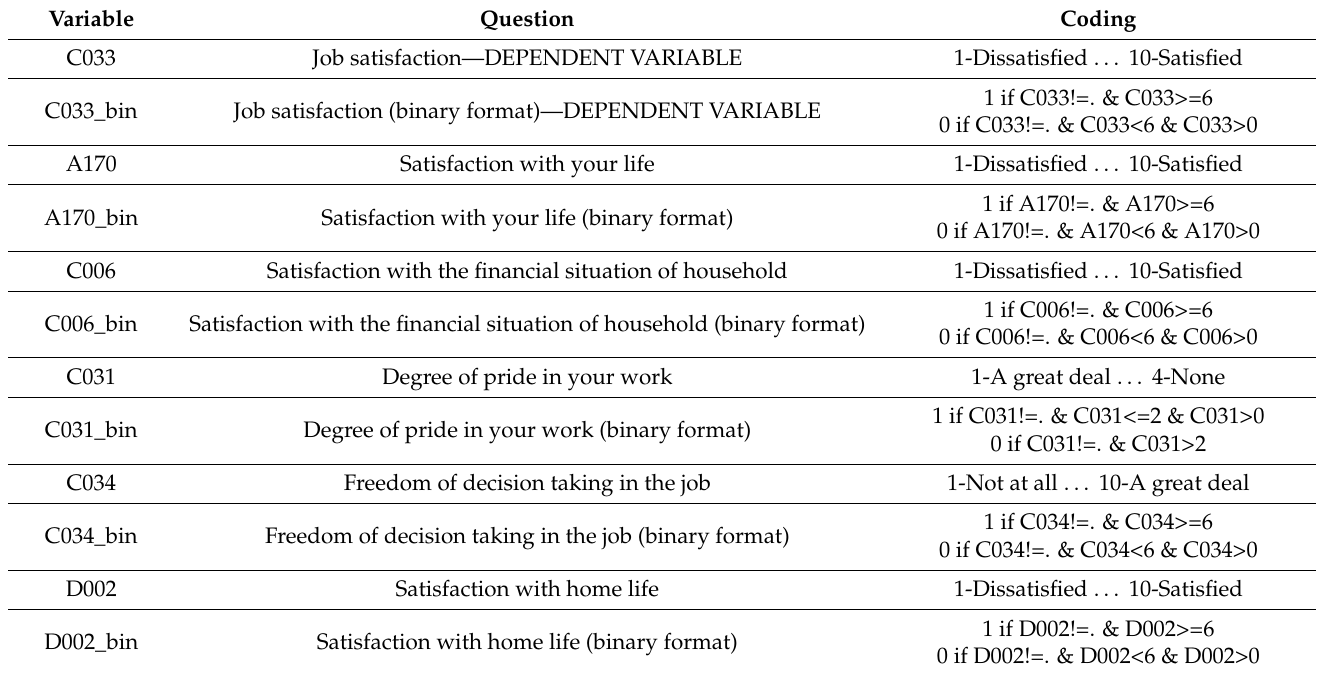
Table A1. The outcome and the most resilient five possible predictors selected after using PCDM, LASSO, and BMA.